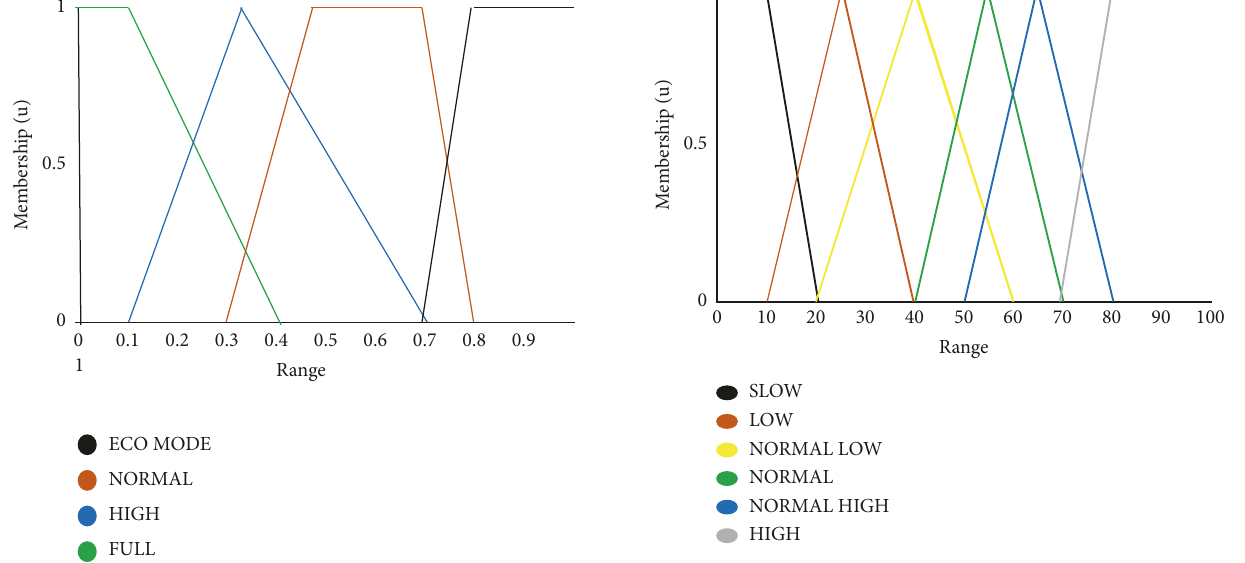
Figure 7: Output variable CORRECTED